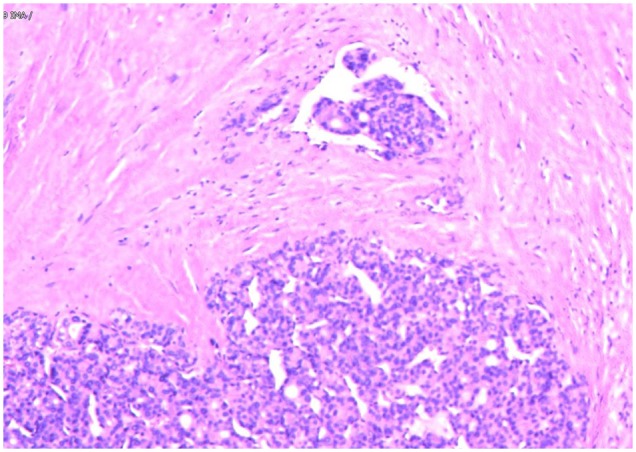
Follicular thyroid carcinoma. (Hematoxylin and eosin staining of histological slides, × 200).